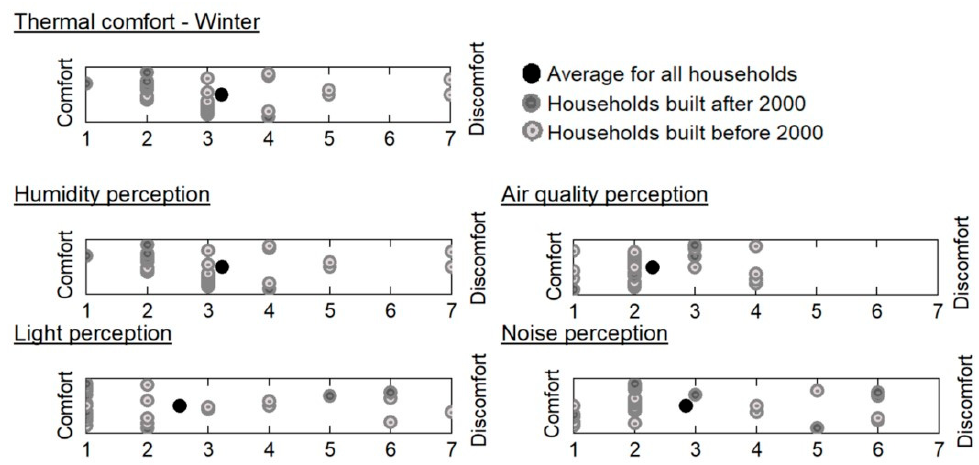
Figure 2. Satisfaction level perception. Only one answer per survey. Temperature, humidity, air quality, natural illumination and noise.